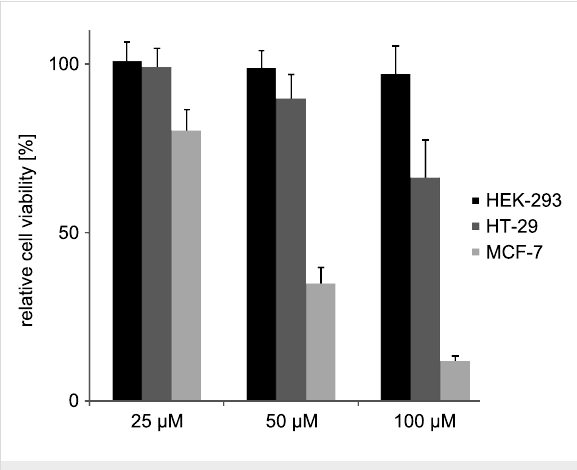
Figure 3: Cell viability of different cell lines after 24 h incubation with